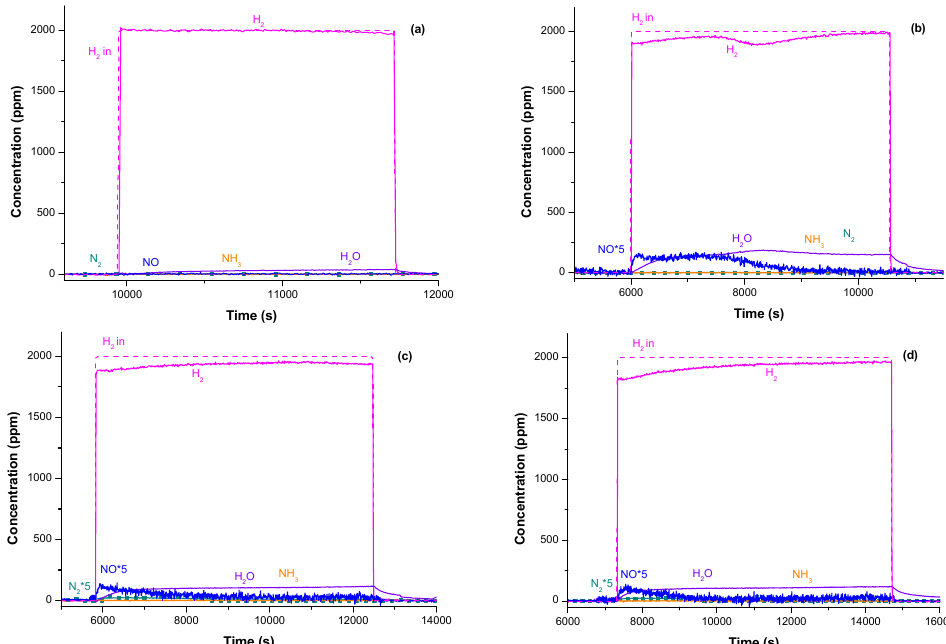
Figure 2. H 2 , N 2 , NH 3 , NO, NO 2 , and H 2 O outlet concentrations, and H 2 inlet profile (in dotted lines) of the reduction step under 2000 ppm H 2 , at 150 °C, for the catalysts: ( a ) CZ; ( b ) Cu2/CZ; ( c ) Ba6/Cu2CZ; and ( d ) Ba11/Cu2CZ (Ba6/CZ not included due to very low catalytic response).